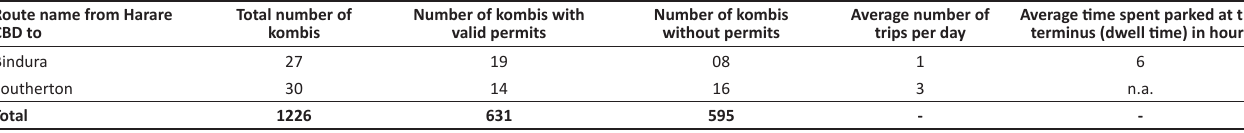
TABLE 4 (Continues...): Harare termini capacity and other kombi operational characteristics. Route name from Harare CBD